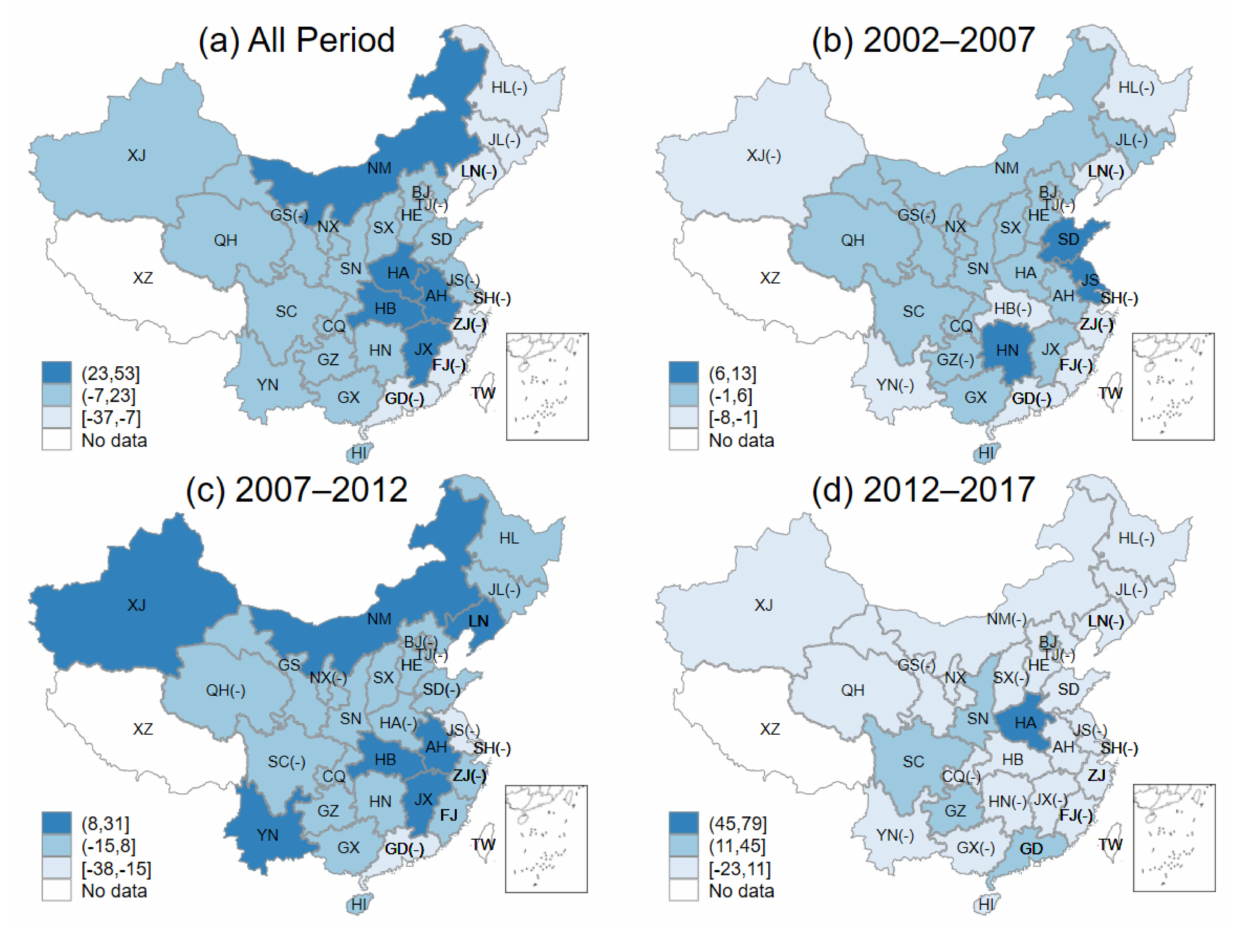
Figure 4. Provincial homothetic regional green investment competition effect: ( a ) all periods; ( b ) 2002–2007; ( c ) 2007–2012; ( d )